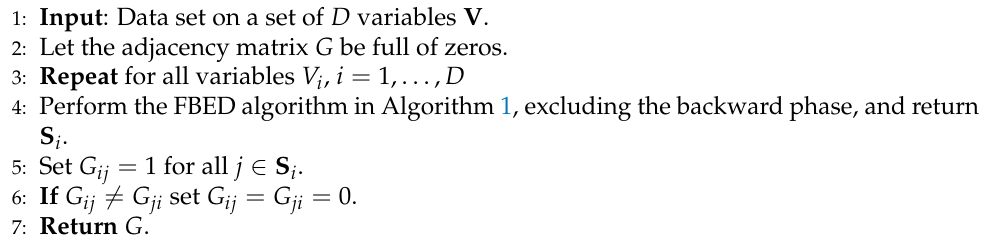
Algorithm 2 Skeleton identification phase of the FEDHC